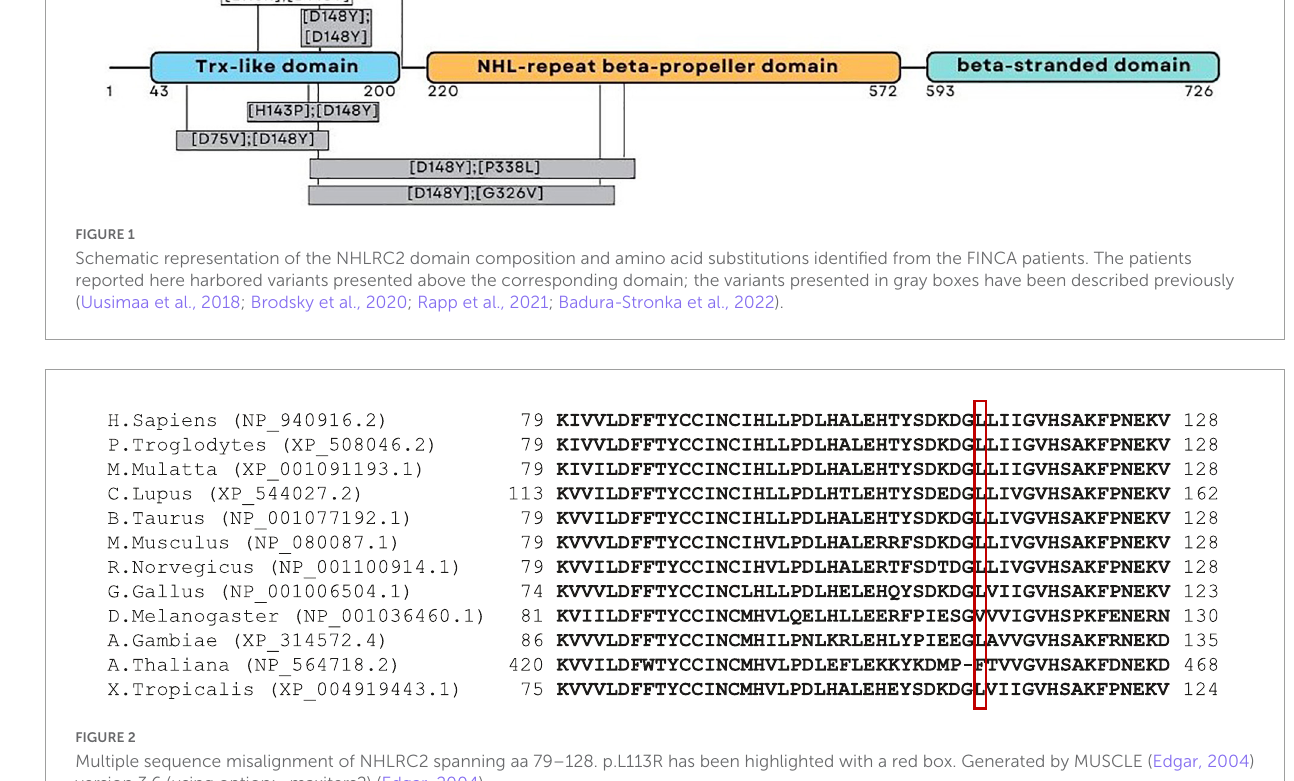
and in the adult hippocampus, suggesting a role for dysregulated RNA metabolism in FINCA